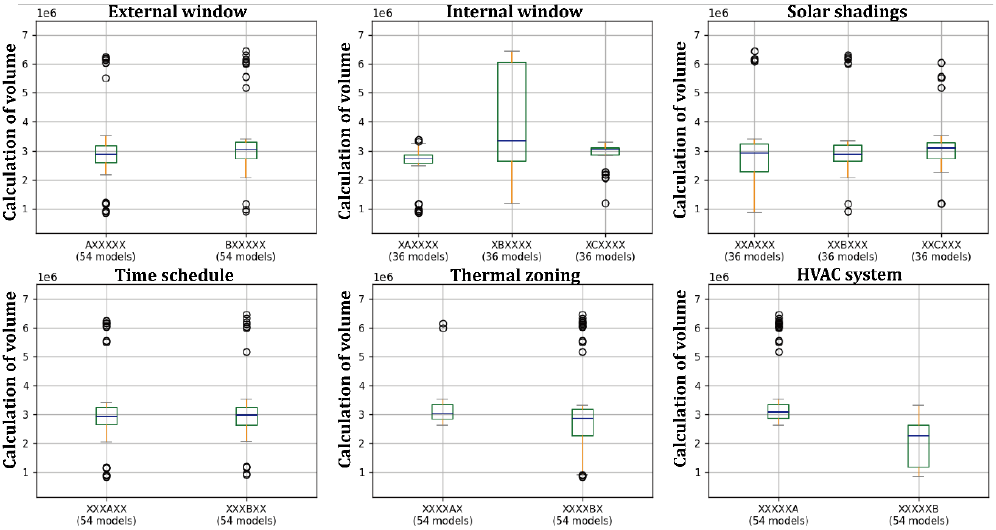
Figure 11. The boxplot for the six input parameters for the building against computational load. Table 7. The analysis of U-testing for the computational-load boxplot.